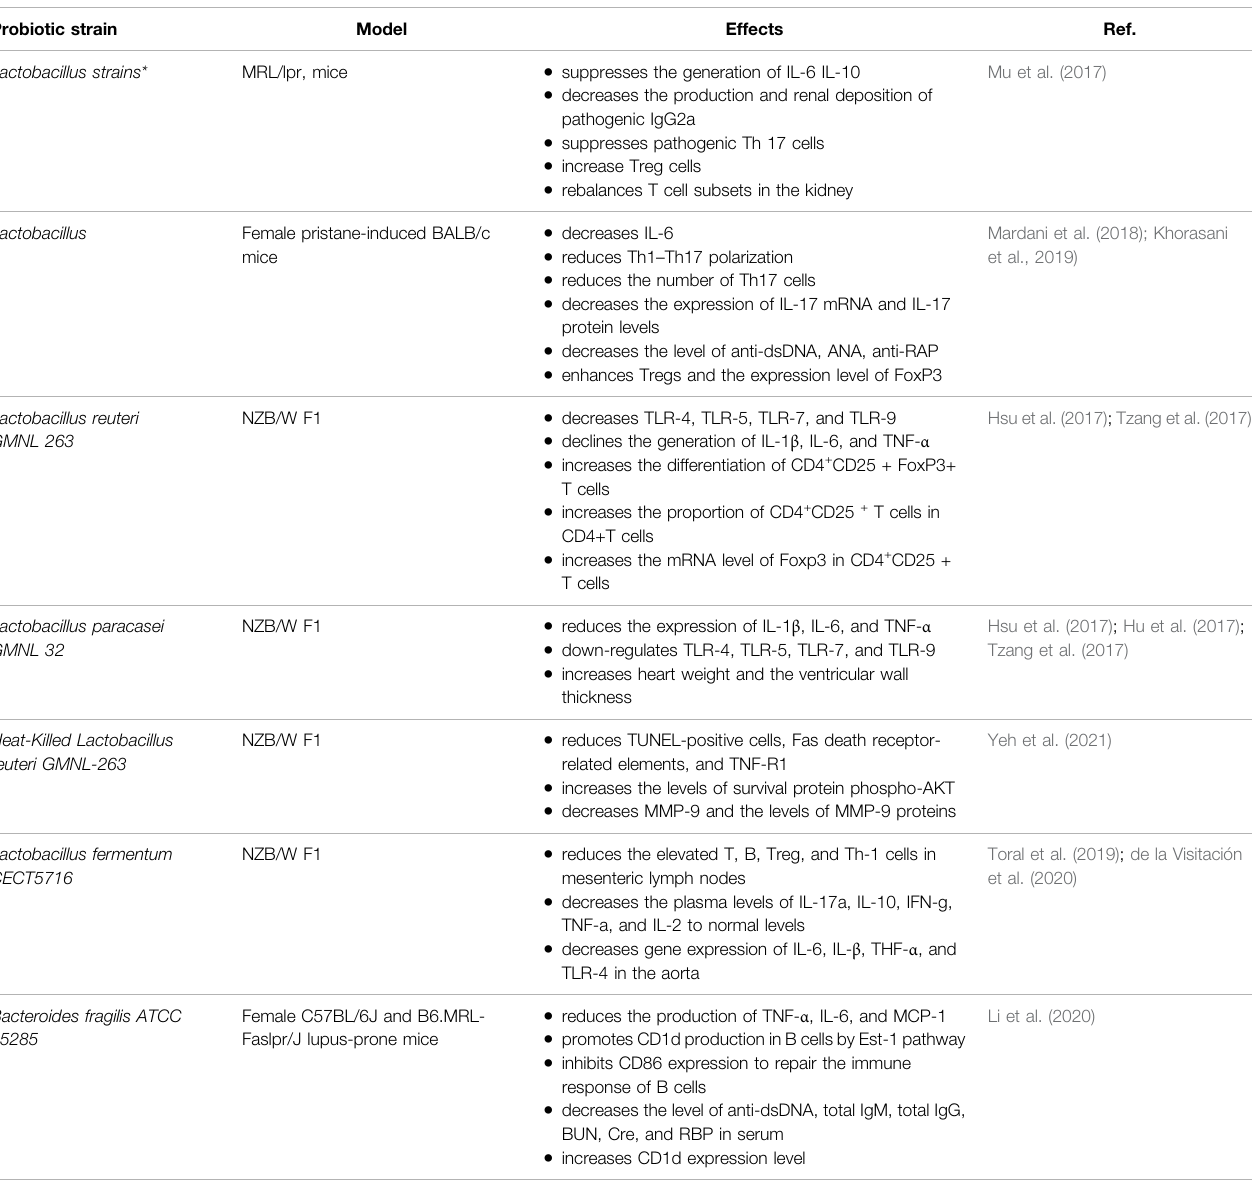
TABLE 2 | Effects of probiotics in SLE animal models. Probiotic